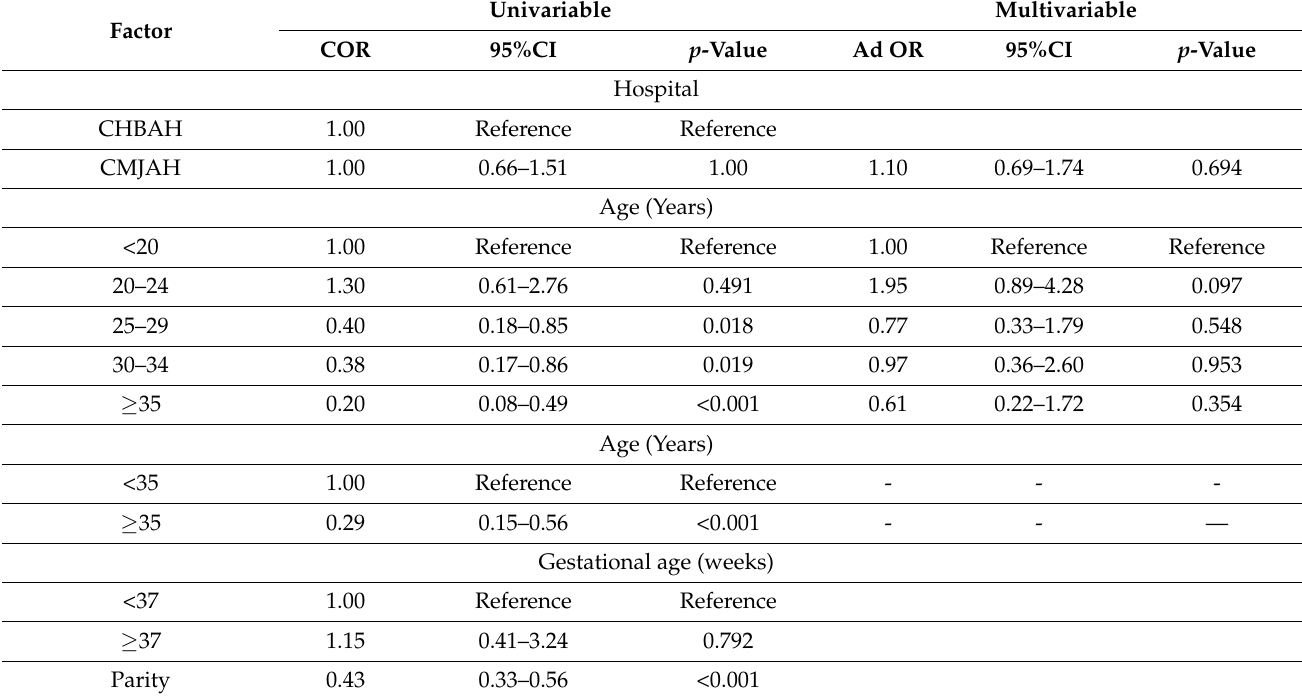
Table 3. Univariable and multivariable regression of the association between sociodemographic and clinical characteristics and operative vaginal